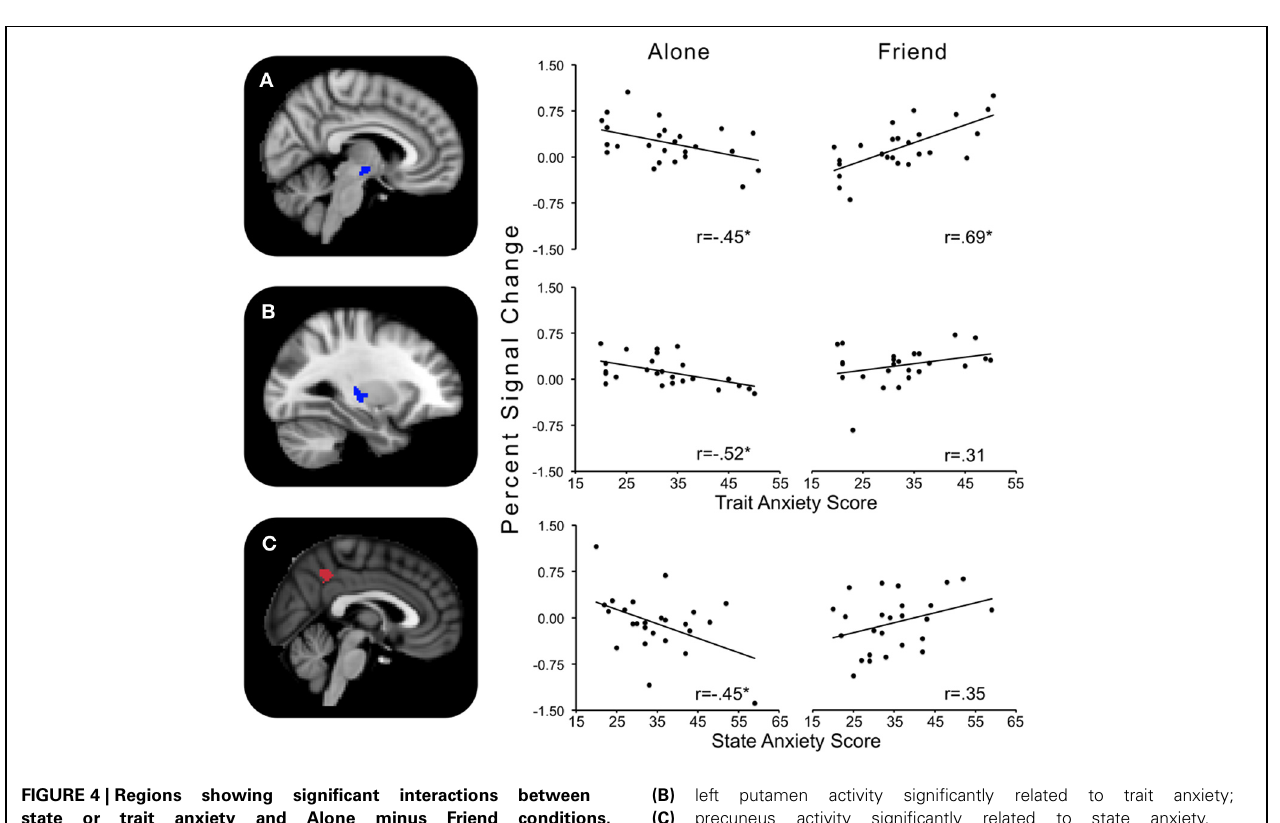
FIGURE 4 | Regions showing significant interactions between state or trait anxiety and Alone minus Friend